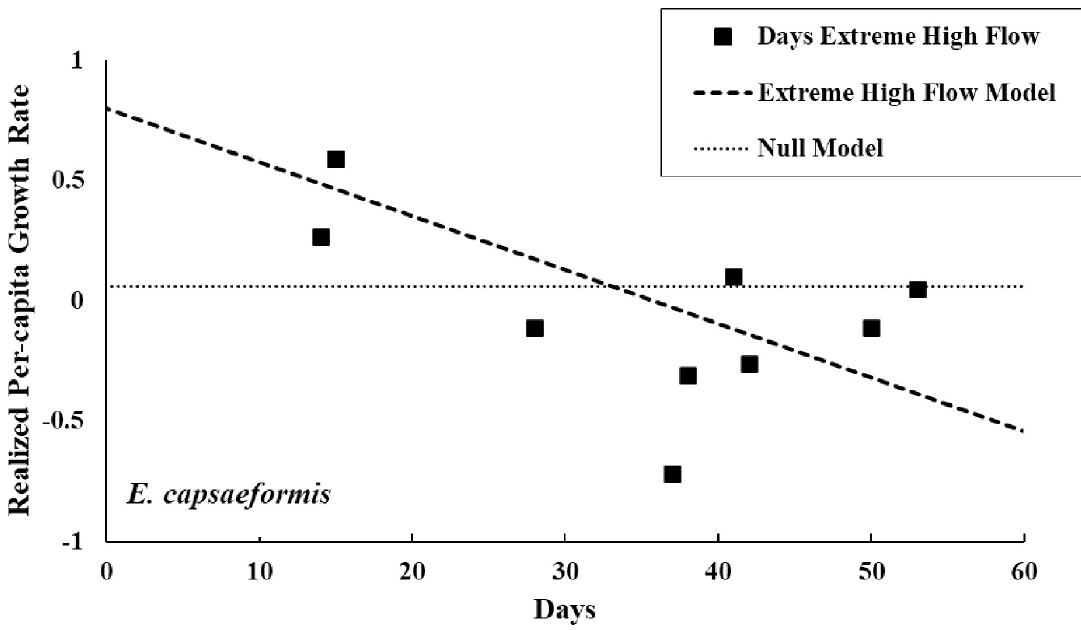
Fig 13. The number of days with extreme high discharge ( � 90 th percentile of flows 1931–2014) in a year was negatively associated with realized per-capita growth rate for E . capsaeformis . Growth rate was calculated using juveniles and